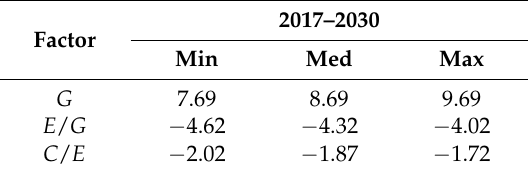
Table 3. Annual average rate of change in each factor for the baseline scenario. Unit: